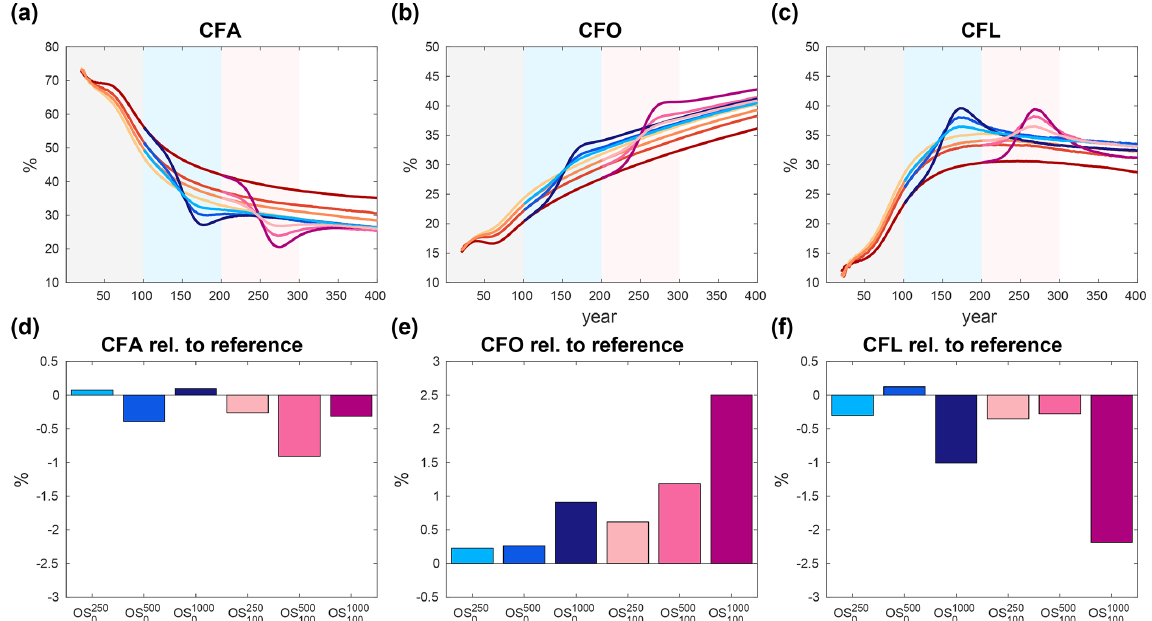
Figure 4. Cumulative airborne (a) , ocean (b) , and land (c) fractions of emissions in percent of total emissions. Panels (d) – (f) show the deviation of the overshoots relative to the reference simulation without overshoot for the airborne (d) , ocean (e) , and land (f) fractions at the end of the simulations (year 400). The colour code for the simulations is given in Fig. 1. The shaded areas in the background of panels (a) – (c) indicate the different phases of the simulations (grey: positive emissions; light blue: negative emissions for the short overshoots; light red: negative emissions for the long